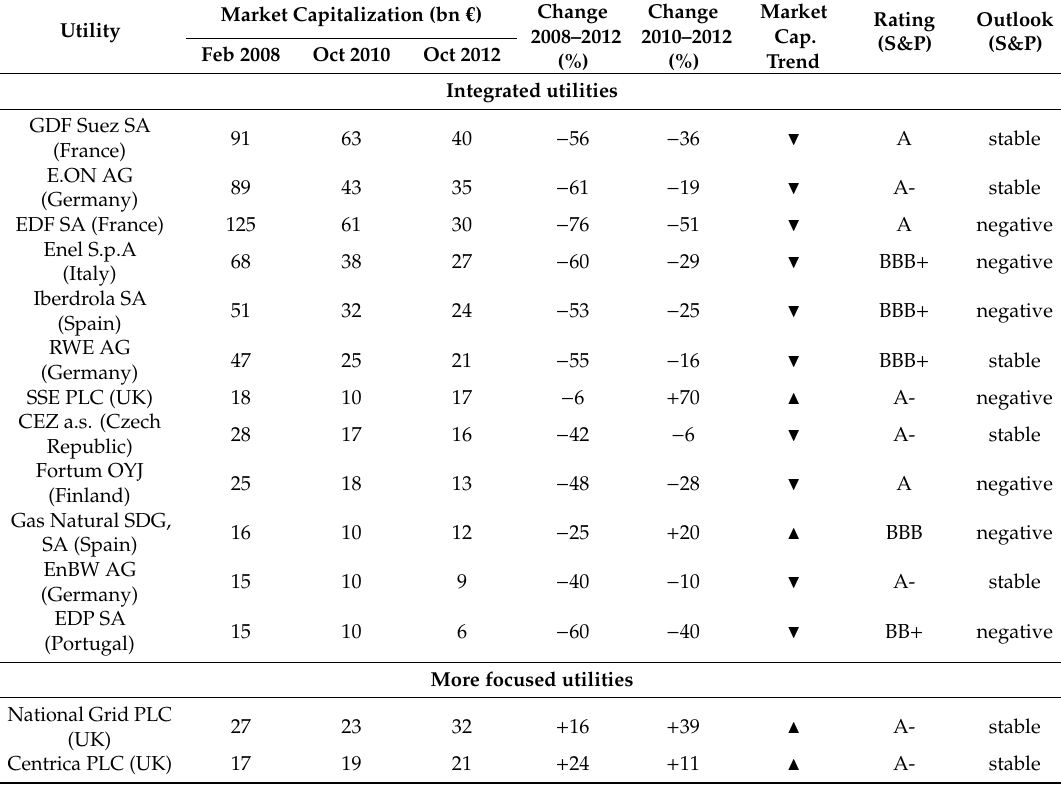
Table 2. Overview of the development of the biggest European utilities in terms of market capitalization from 2008 until 2012 and performance outlook at that